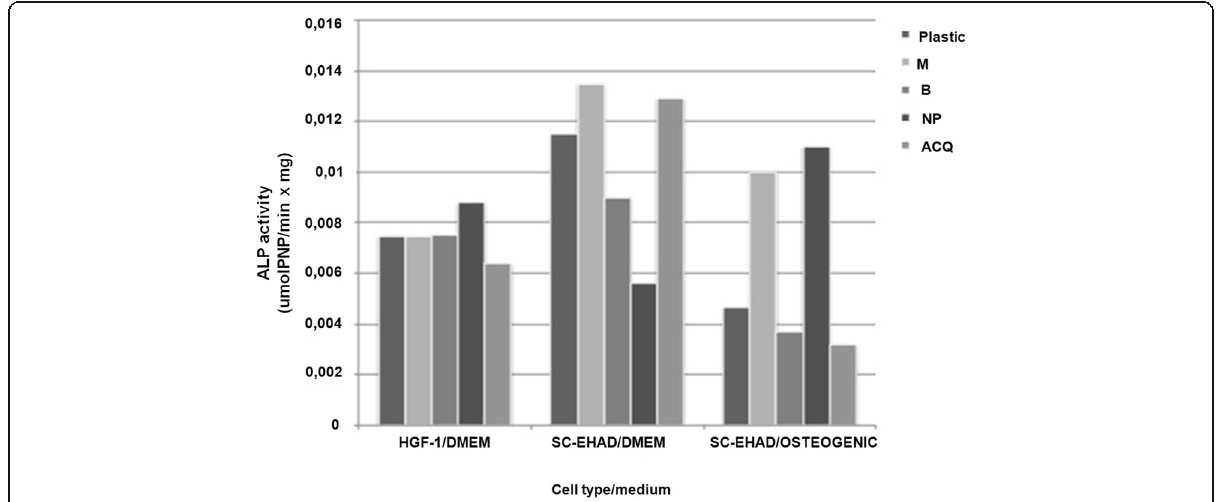
Fig. 7 ALP activity of HGF-1 and SC-EHAD cells [DMEM (standard) and osteogenic